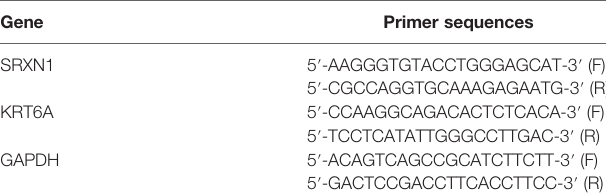
TABLE 1 | Primer sequences used in